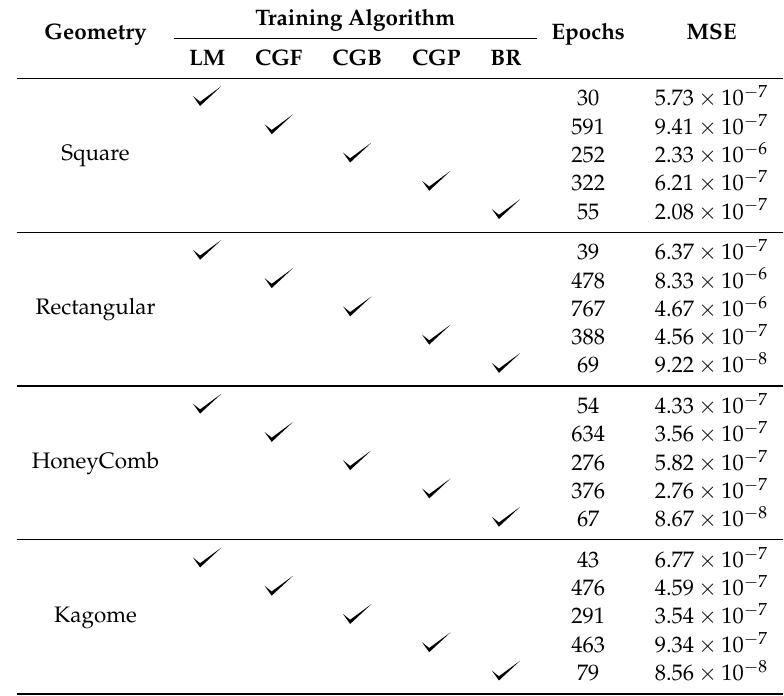
Table 2. Comparison of various ANN’s training algorithms as used in benchmark